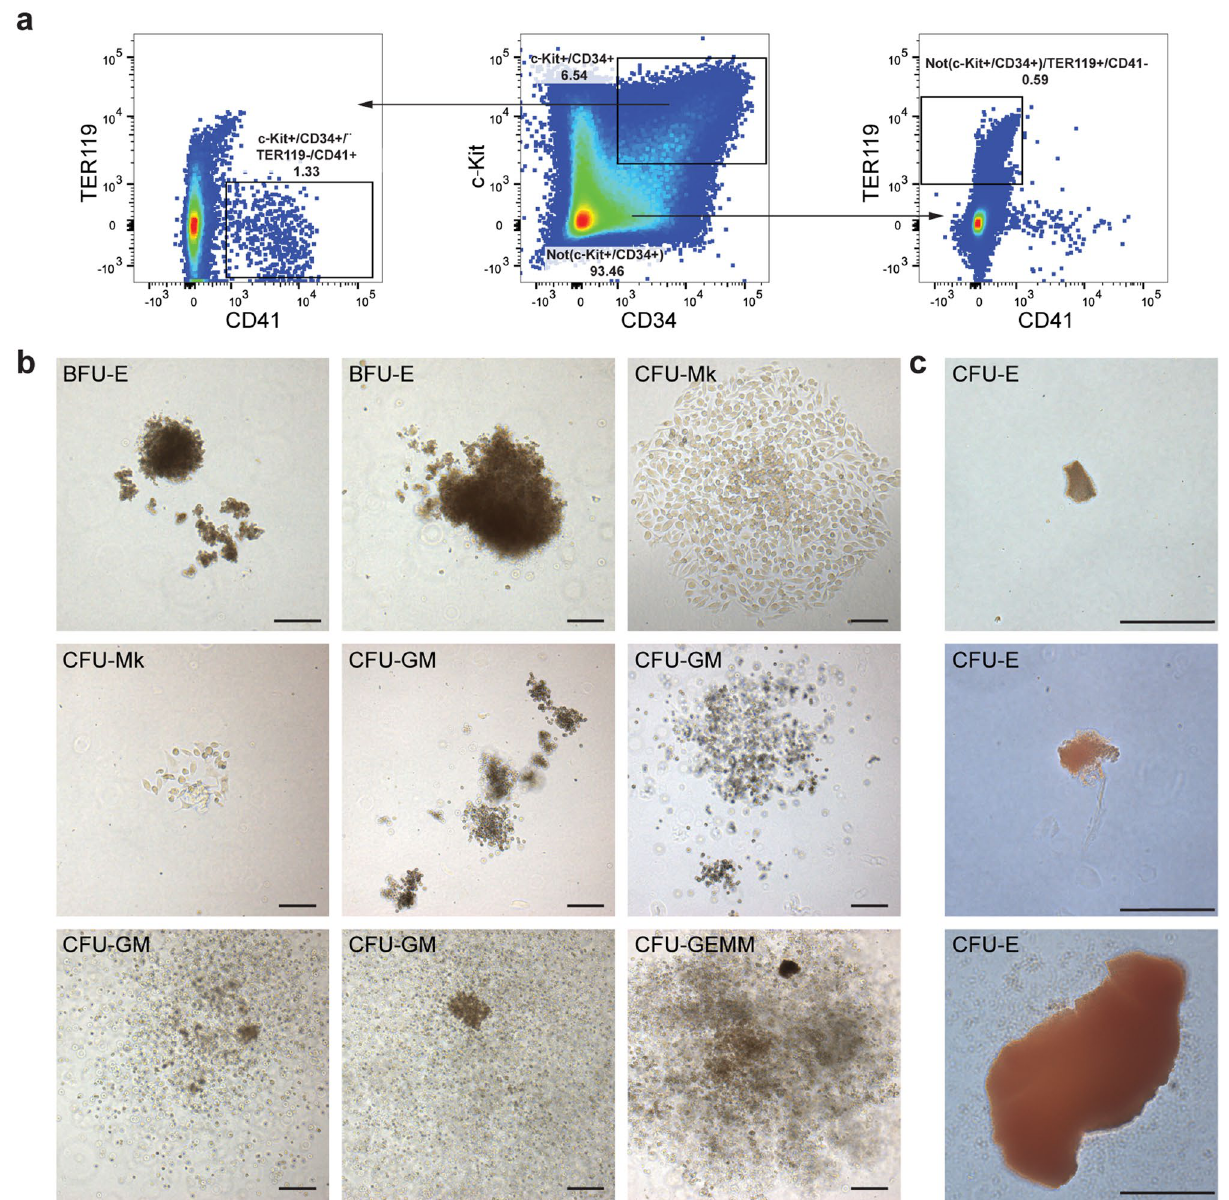
Figure 4. Multilineage clonogenic potential of gastruloid-derived blood progenitors. ( a ) Gating strategy for the isolation of c-Kit + /CD34 + /TER119 − /CD41 + hematopoietic progenitors and Not(c-Kit + /CD34 + )/TER119 + /CD41 − primitive erythroid cells from Gata6-Venus gastruloids at 168 h. ( b ) Representative images of BFU-E, CFU-Mk, CFU-GM, CFU-E and CFU-GEMM colonies derived from c-Kit + /CD34 + /TER119 − /CD41 + cells after 17 days of culture in Methocult. ( c ) Representative images of CFU-E colonies derived from the Not(c-Kit + /CD34 + )/ TER119 + /CD41 − population after 17 days of culture in Methocult. BFU-E burst-forming-unit-erythroid, CFU-Mk colony forming unit-megakaryocyte, CFU-GM colony forming unit-granulocyte, macrophage, CFU- GEMM colony forming unit-granulocyte, erythroid, macrophage, megakaryocyte, CFU-E colony forming unit-erythroid. In this Figure, we refer to the remaining cells after gating for c-Kit + /CD34 + cells as Not(c-Kit + / CD34 + ). Notably, the Not(c-Kit + /CD34 + ) population still contains single positive cells for c-Kit and CD34. Scale bars 200